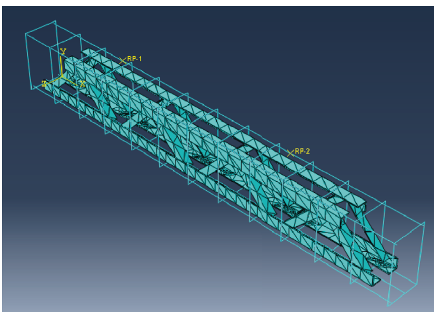
Figure 5: The deflected shape at failure for the embedded steel truss RC beam.